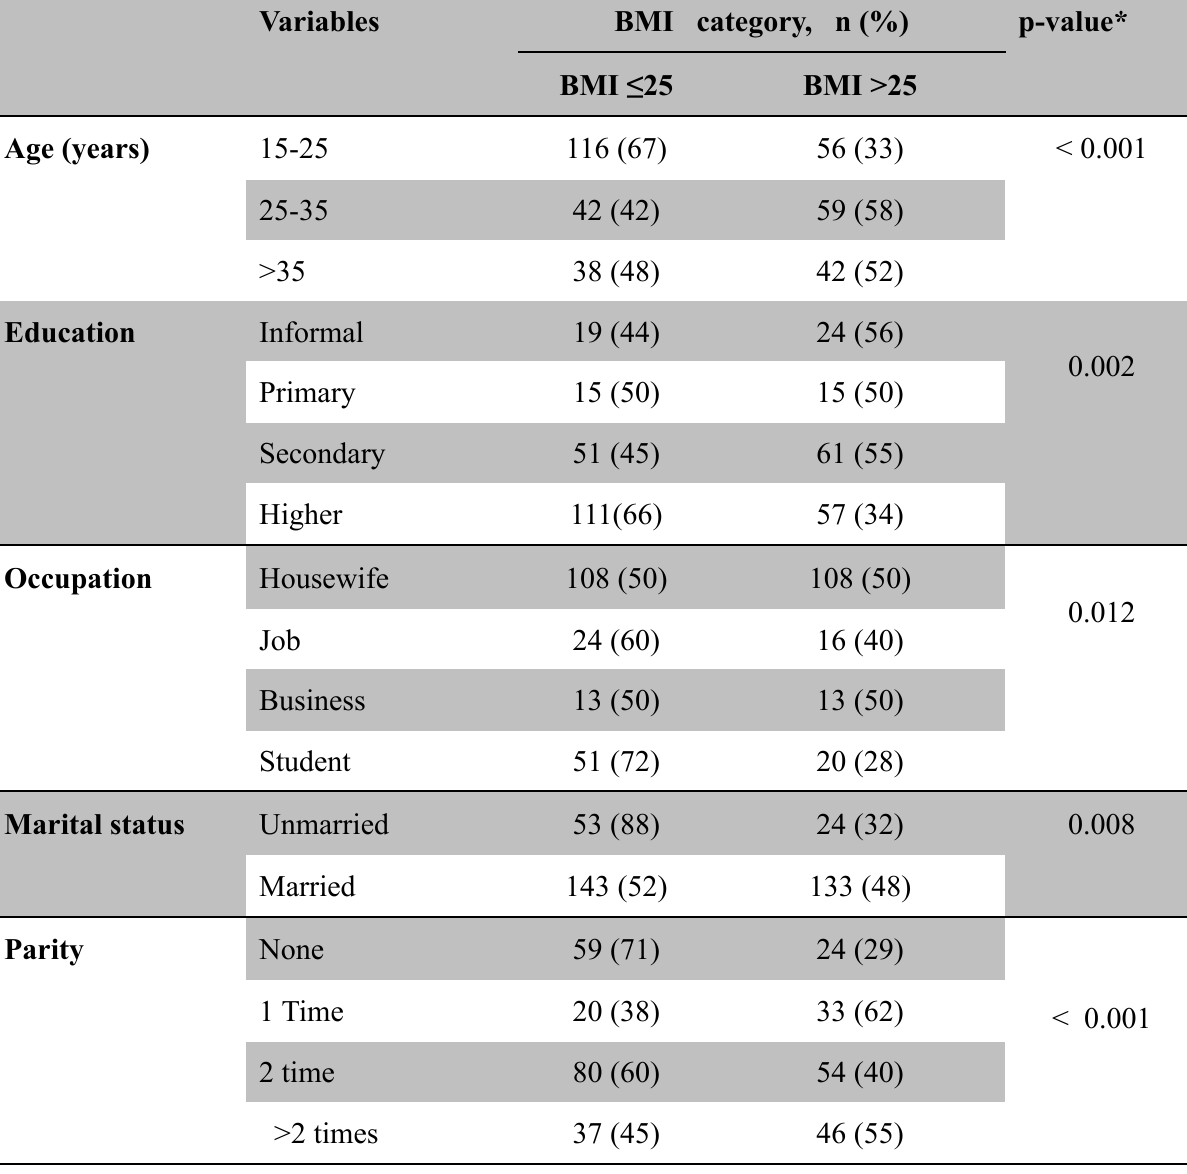
Table 4. Association of obesity with demographic